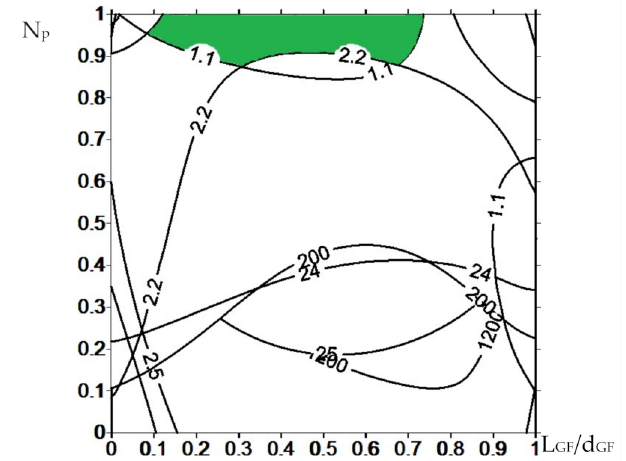
Figure 13. The area determining the number of processing passes and the aspect ratio of the glass filler required to obtain the UHMWPE-based composites with the predefined